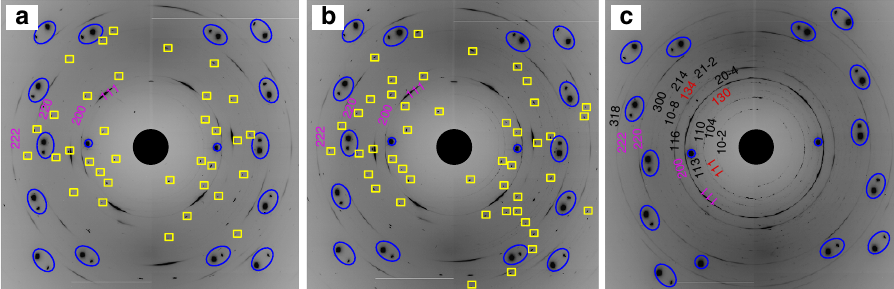
Figure 3 | Selected 2D diffraction images of FeCO 3 before and after heating. Single-crystal diffraction images were collected at 28.7(1) GPa at ( a ) ambient temperature before heating, ( b ) after heating at 1,550(100) K and ( c ) 2,250(100) K. Melting and recrystallization of starting material is evidenced by the appearance of FeCO 3 powder diffraction rings after heating to the highest temperature. Appearance of diffraction lines of HP-Fe 3 O 4 indicates incongruent melting of FeCO 3 . Blue ellipsoids indicate diamond diffraction spots from the diamond anvils and yellow squares mark the single-crystal diffraction spots of FeCO 3 . Numbers designate hkl-indices of diffraction lines belonging to FeCO 3 (black), neon pressure transmitting medium (magenta) and HP-Fe 3 O 4 (red).